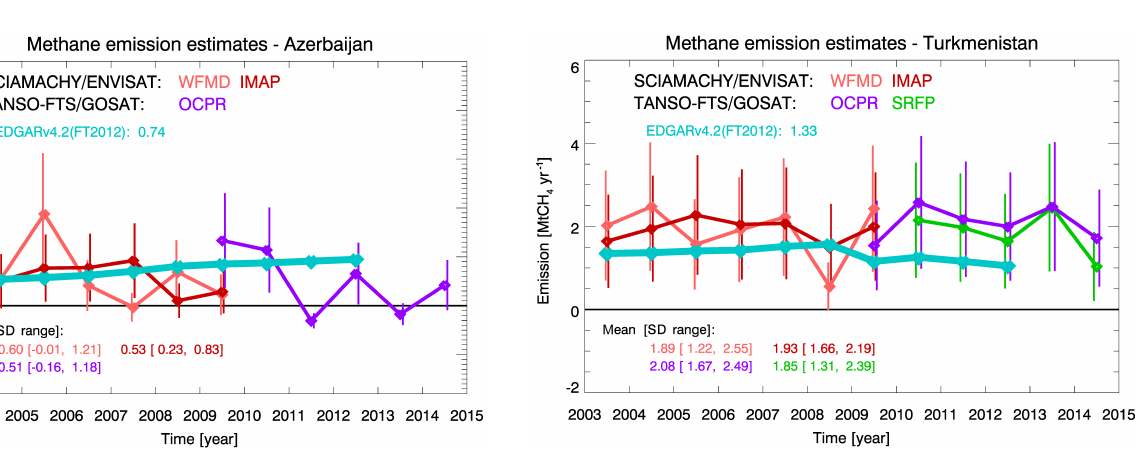
Figure 20. Annual methane emission estimates for Azerbaijan (see also Fig. 19). The blue line shows the EDGAR v4.2 (FT2012) an- nual emissions for Azerbaijan.